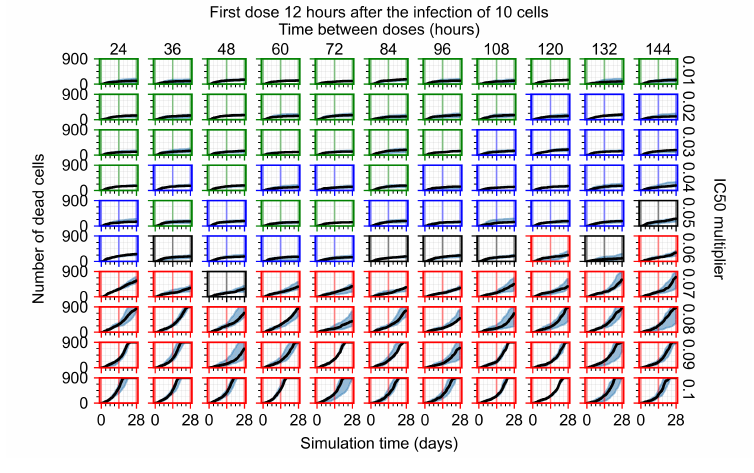
Figure A87. Dead population.